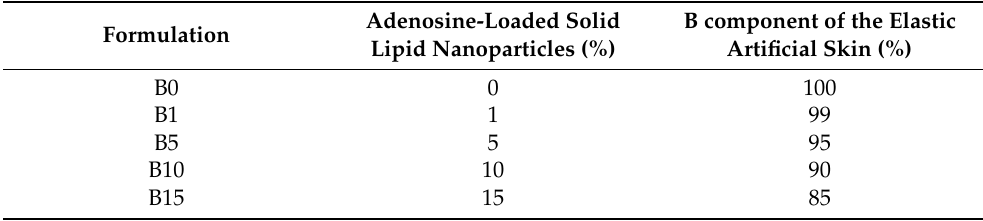
Composition of the elastic artificial skin incorporated with adenosine-loaded solid lipid